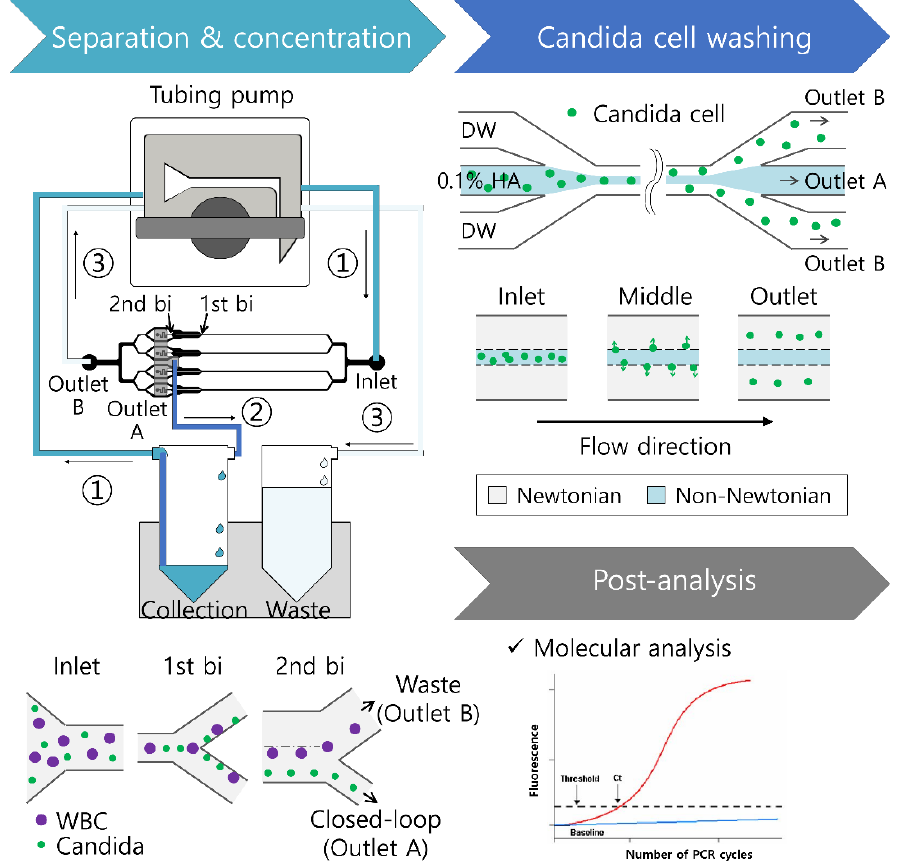
Figure 1. Schematic of continuous separation, concentration, and purification of candida cells using viscoelastic fluid.